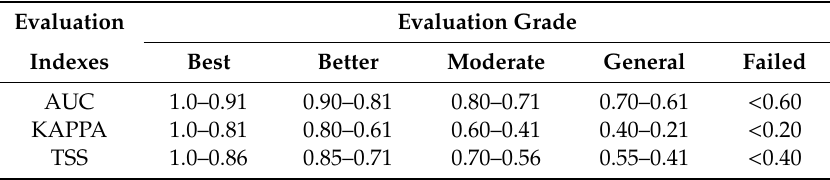
Table 2. Evaluation indexes and evaluation grades of the